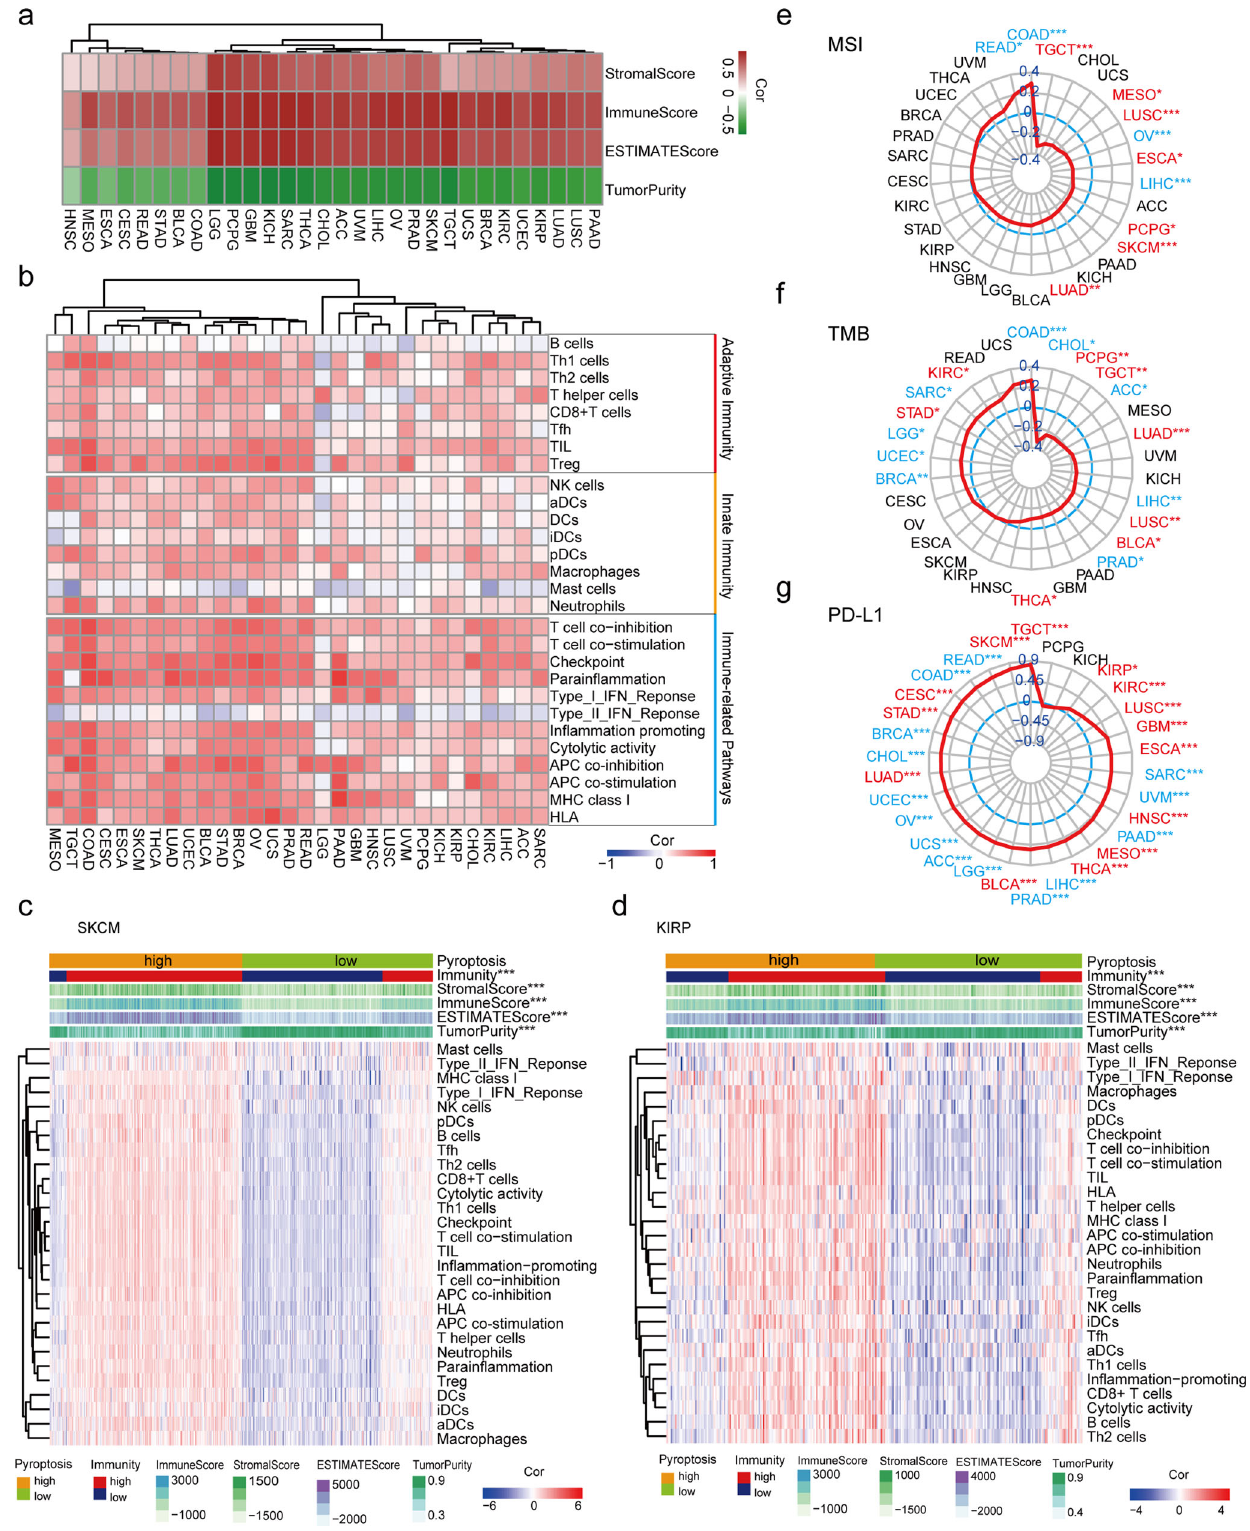
Fig. 2 Correlation analysis between pyroptosis signature and immune-related signatures across 30 cancer types. a , b The relationship between normalized enrichment score of the pyroptosis-associated genes (NESPAGs) and tumor environment scores ( a ), as well as immune-related signatures ( b ). c , d The heatmap of tumor microenvironment scores and immune activity between high and low NESPAGs group in skin cutaneous melanoma (SKCM) ( c ) and kidney renal papillary cell carcinoma (KIRP) ( d ) cohorts. e – g The correlation of pyroptosis with microsatellite instability (MSI) ( e ), tumor mutational burden (TMB) ( f ), and programmeddeath-ligand 1 (PD-L1) ( g ) across 30 cancer types. P values were calculated using the Spearman correlation test or Wilcoxon rank- sum test (* P <0.05; ** P < 0.01; *** P < 0.001). The blue color text indicates “ cold cancer ” , while the red color text indicates “ hot cancer ” . Tfh T follicular helper, TIL tumor-in fi ltrating lymphocyte, aDC activated dendritic cells, iDC immature DCs, NK cells natural killer cells, pDC plasmacytoid dendritic cells. COMMUNICATIONS BIOLOGY| (2022) 5:917